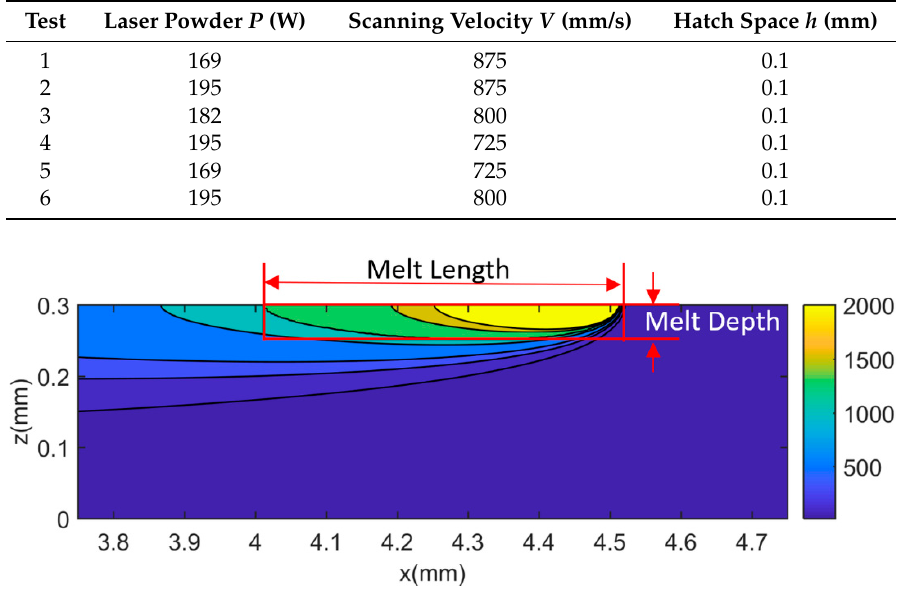
Figure 2. Predicted temperature distribution and molten pool geometry under test 6 process conditions, using 40% absorption. It should be noted that the color bar values correspond to the temperature contours.